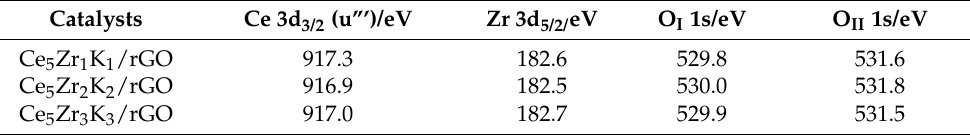
Table 3. Binding energies of Ce 3d 3/2 (u ‴ ), Zr 3d 5/2 , O Ⅰ 1s, and O Ⅱ 1s of CeZrK/rGO catalysts.